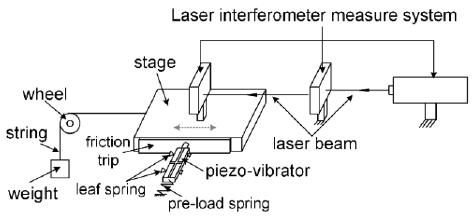
Figure 9. Testing system of velocity vs. tension.